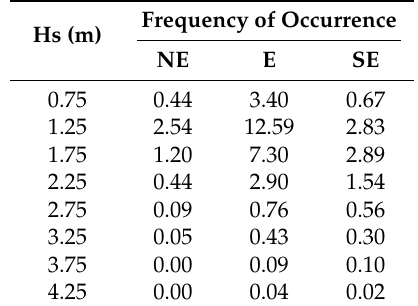
Table 8. Wave climate at Imbituba Port, summarized in percentage of occurrence during the year, for three main